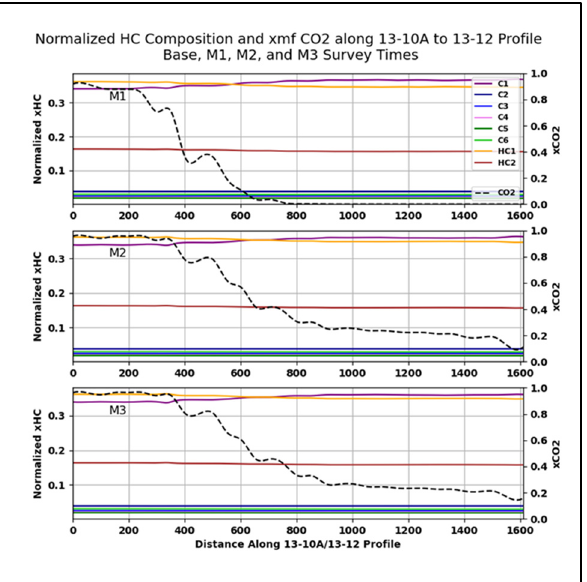
Figure 14. Simulated CO 2 mole fraction and normalized hydrocarbon mole fractions along the 13-10A-13-12 study profile at M1 ( top ), M2 ( center ), and M3 ( bottom ) survey times.